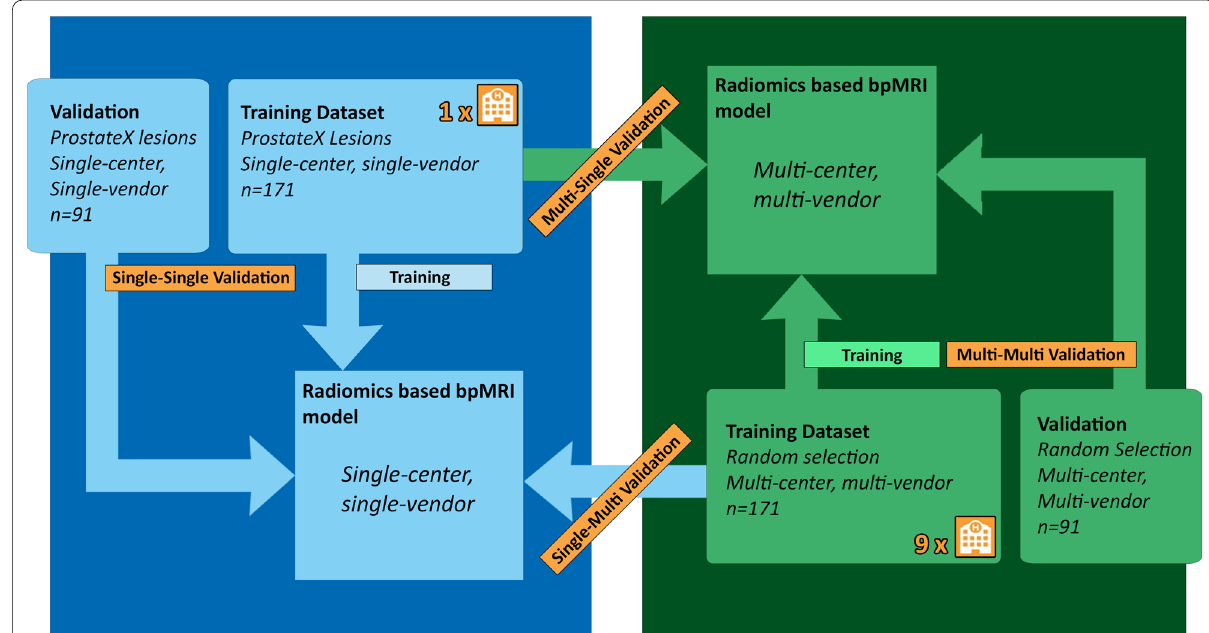
Fig. 1 Validation overview with the development datasets and each of the validations described. Single–single validation single-vendor model validated on single-center, single-vendor data. Multi–multi-validation multi-center, multi-vendor data. In the multi–single and single–multi-combinations, the first word refers to the model, while the second refers to the